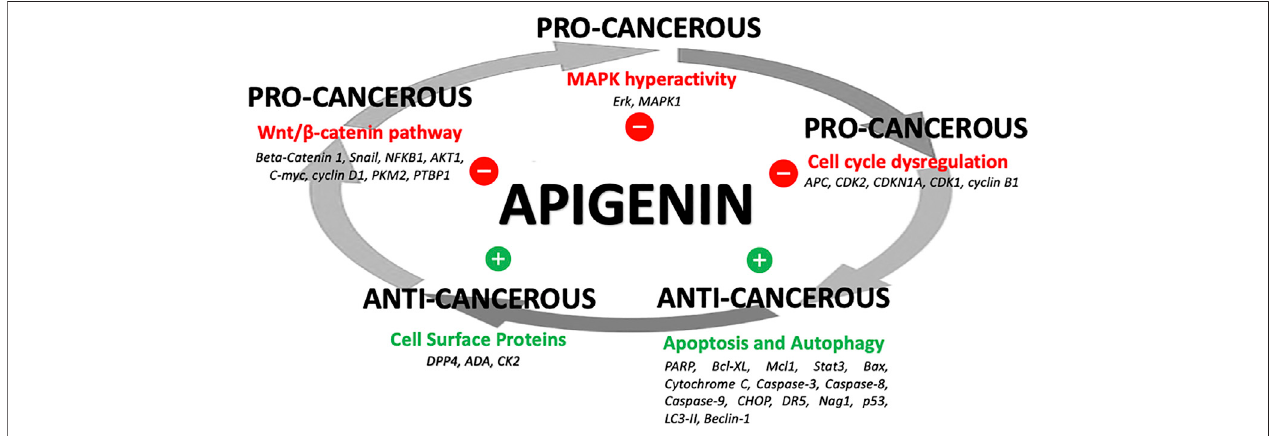
FIGURE 4 | Apigenin in fl uences on cancer processes. A summary of how apigenin is a key regulator in a number of linked cellular pathways, inhibiting pro- cancerous activity or promoting anti-cancerous activity, yielding a potential overall anti-cancer effect.